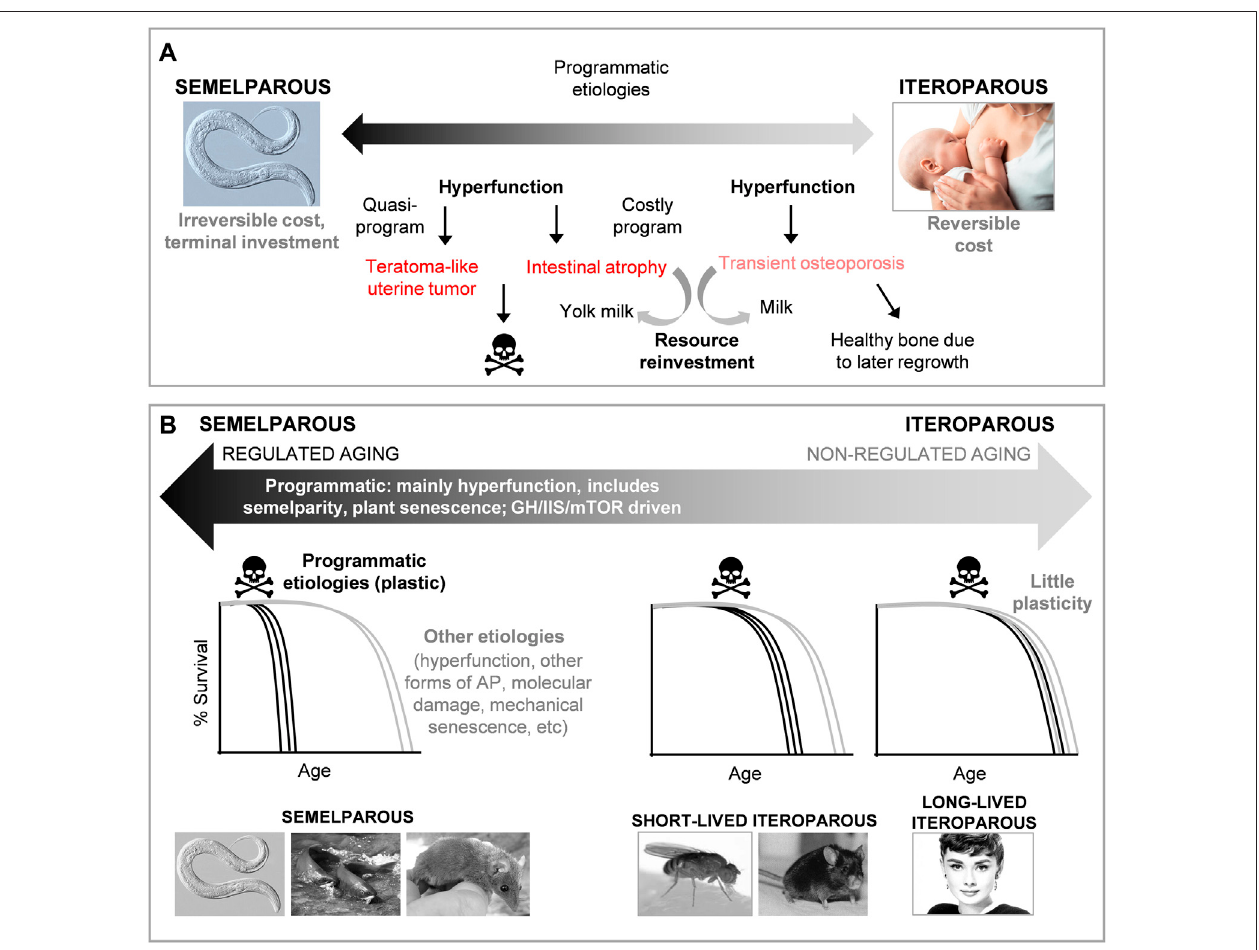
FIGURE 3 | The relationship between aging in semelparous and iteroparous organisms. (A) Aging in semelparous and iteroparous organisms lie on a single etiologicalspectrum.Semelparityevolvesfromiteroparity,includingampli fi cationofcostlyprogramspresentinthelatter.Thesechangefrombeingmildandreversible,to severe and terminal. (B) Regulated vs. non-regulated aging. Levels of phenotypic plasticity in aging vary greatly between organisms, being greatest in semelparous organisms, and smallest in long-lived iteroparous organisms. The plastic component of aging is regulated and highly programmatic. If such regulated aging is suppressed,morediversemechanismsofagingmaybecomelifelimiting,includingothermodesofantagonisticpleiotropy(AP),stochasticmoleculardamage(e.g.,DNA damage), and mechanical senescence. Semelparous organisms shown are C. elegans , Paci fi c salmon ( Oncorhynchus nerka ), and the brown antechinus ( Antechinus stuartii ), a marsupial.